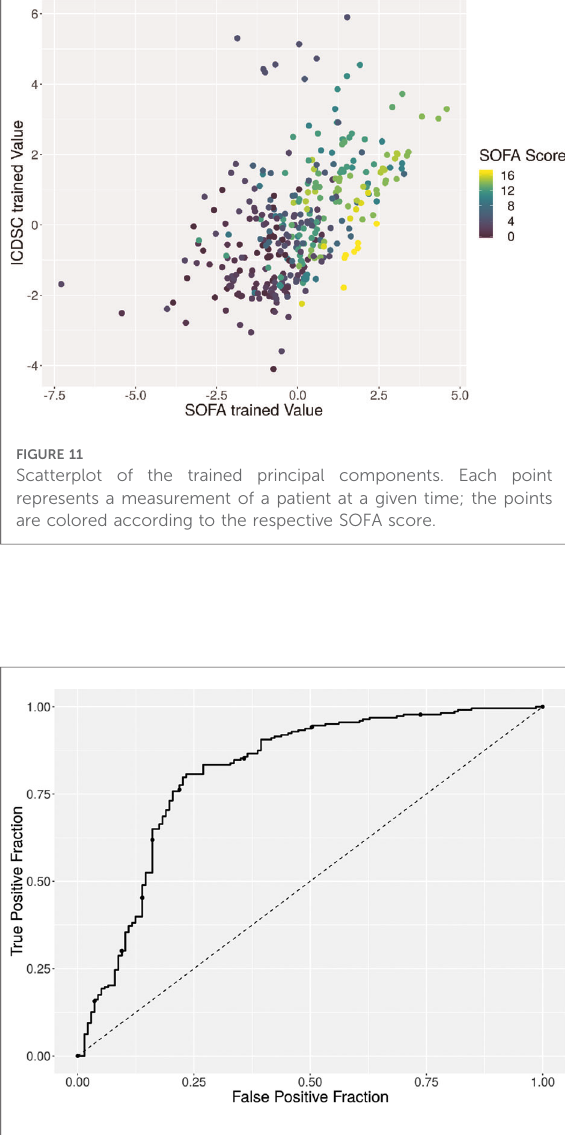
FIGURE 12 ROC curve of the binary classi fi cation of patients into two groups; group 1 with both a SOFA and an ICDSC score of 3 or more and group 2 containing all other measurements. The average accuracy was 83.39%, with an average sensitivity of 75.12% and an average speci fi city of